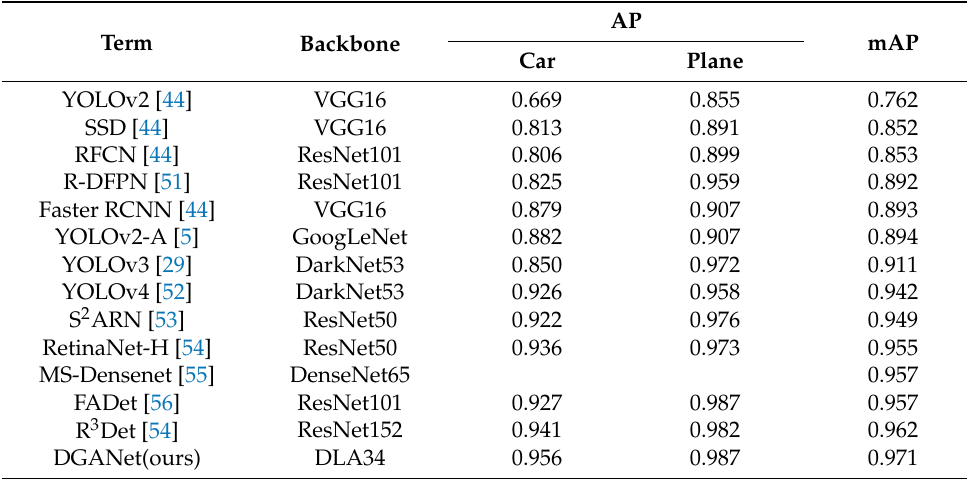
Table 5. Evaluation results for the UCAS-AOD dataset.